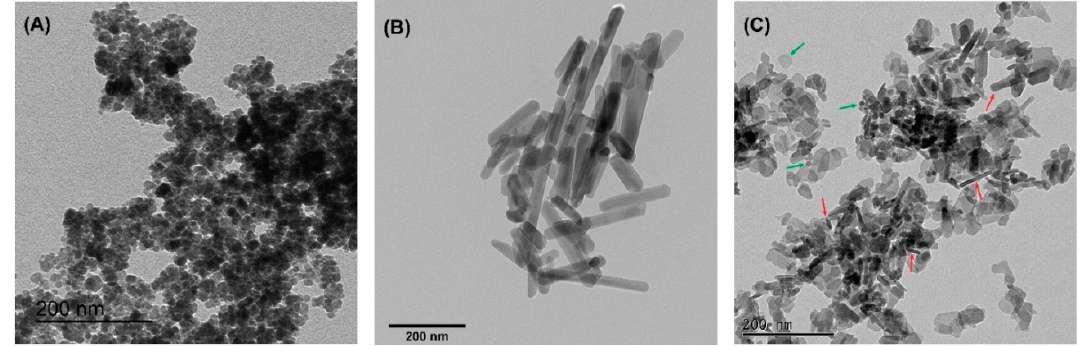
Figure 4. Transmission electron microscopy (TEM) micrographs of the samples ( A ) Fe 3 O 4 , ( B ) HA and ( C ) Fe 3 O 4 -HA. All bars correspond to 200 nm.